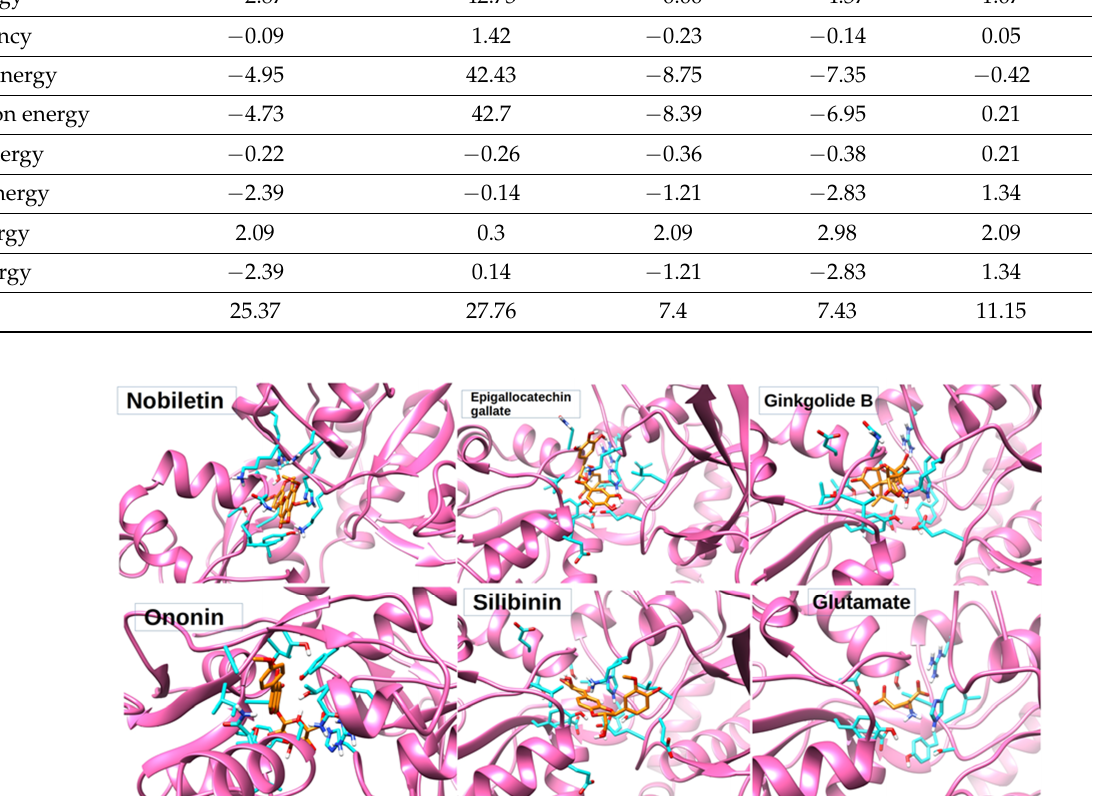
Table 2. Docking scores of nobiletin, ginkgolide B, silibinin, ononin, and epigallocatechin gallate poses with NMDA receptor after rigid docking, as mentioned below.